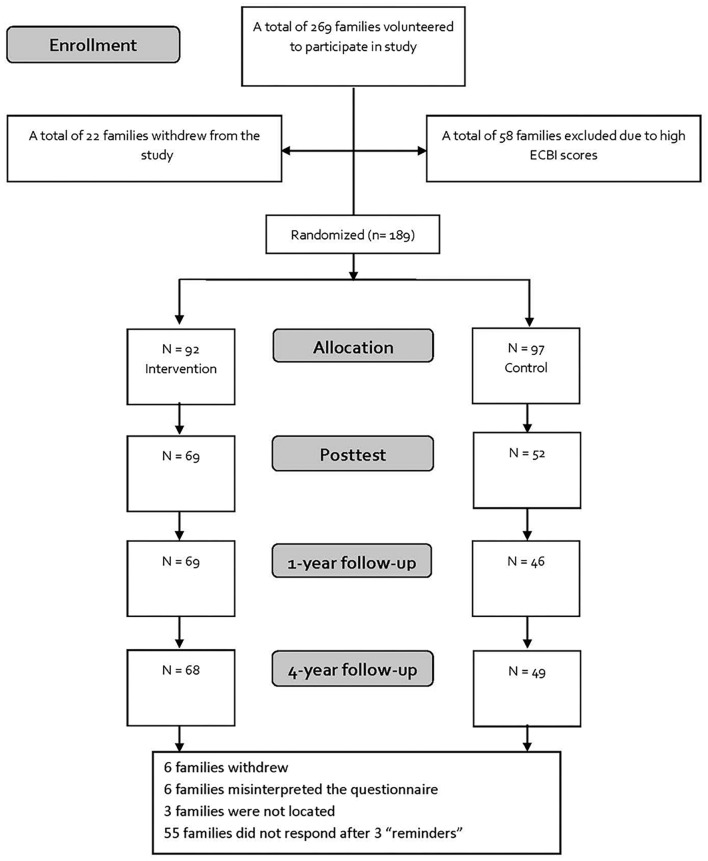
CONSORT flowchart.